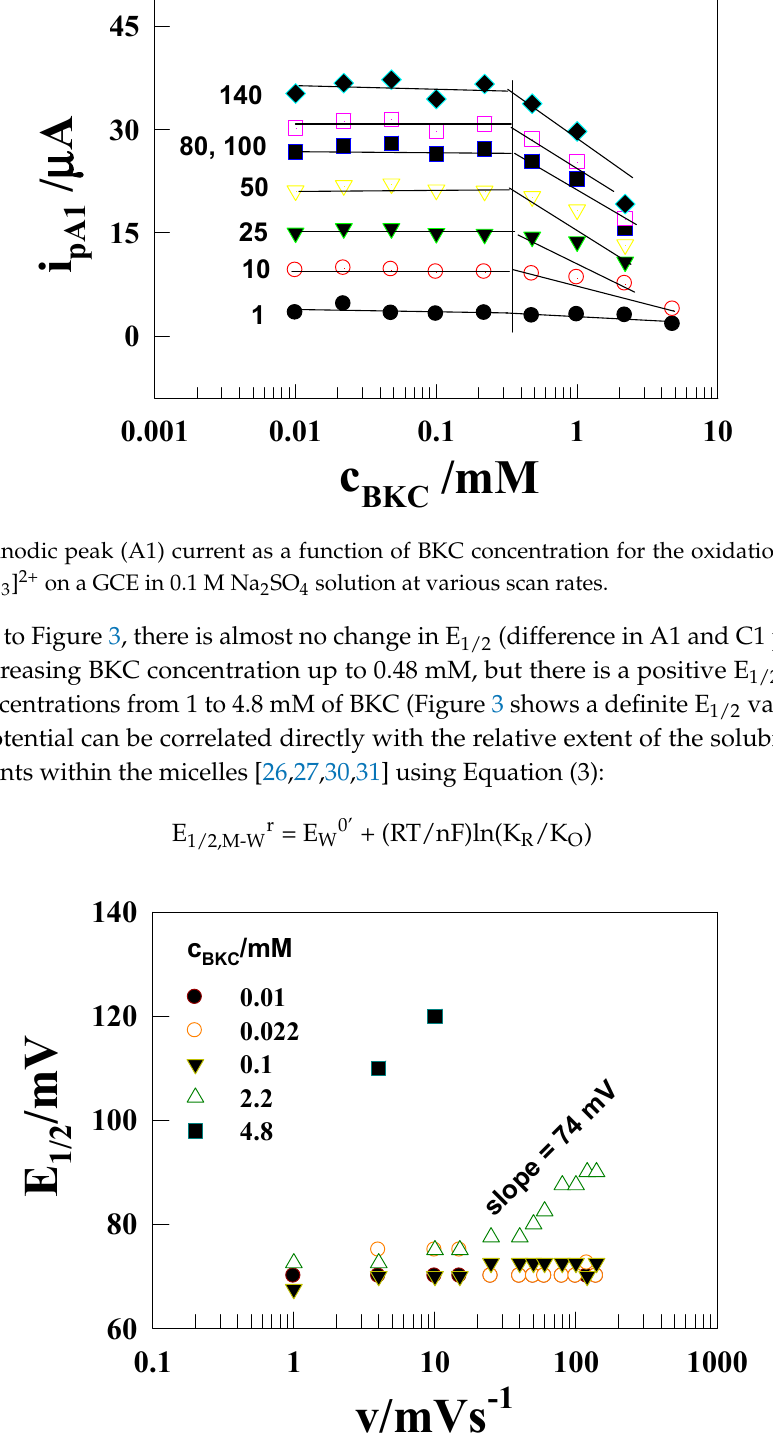
Figure 3. E 1/2 versus log( v ) plots for the oxidation of 1 mM [Co(II)(bpy) 3 ] 2+ on a GCE in 0.1 M Na 2 SO 4 at various concentrations of BKC.